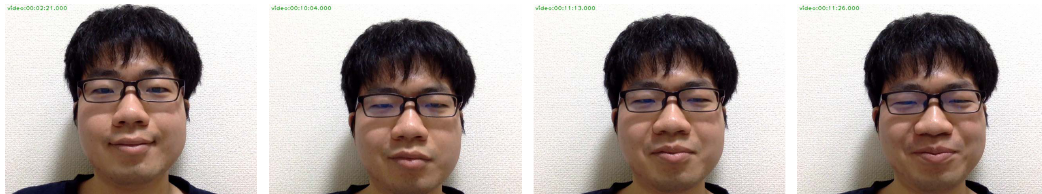
Figure 4. Samples of smiling face images to consider smile